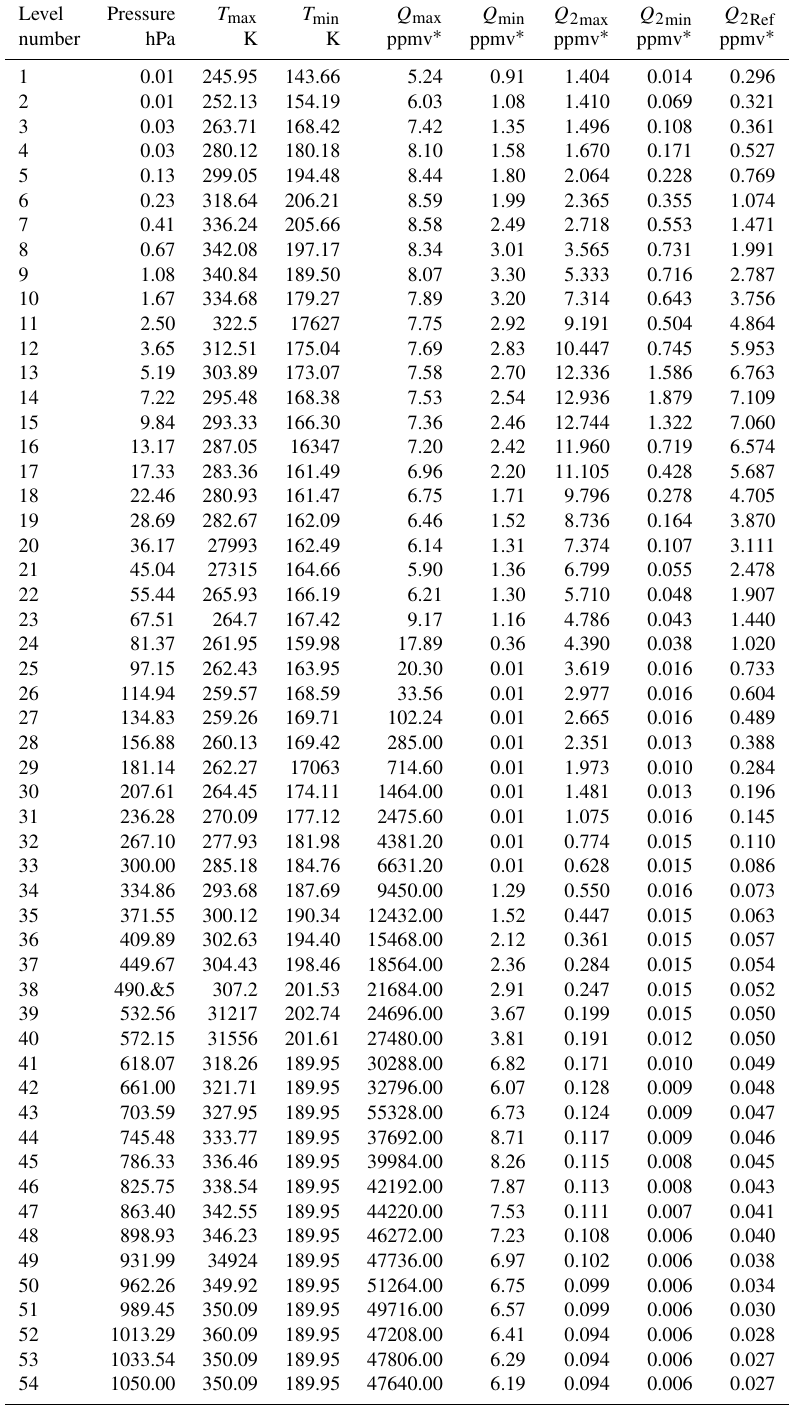
Table A1. Pressure levels adopted for RTTOV v12: 54 pressure level coefficients and profile limits within which the transmittance calcula- tions are valid. Note that the gas units here are ppmv. (From https://www.nwpsaf.eu/site/software/rttov/ last access: 11 January 2020, RTTOV Users